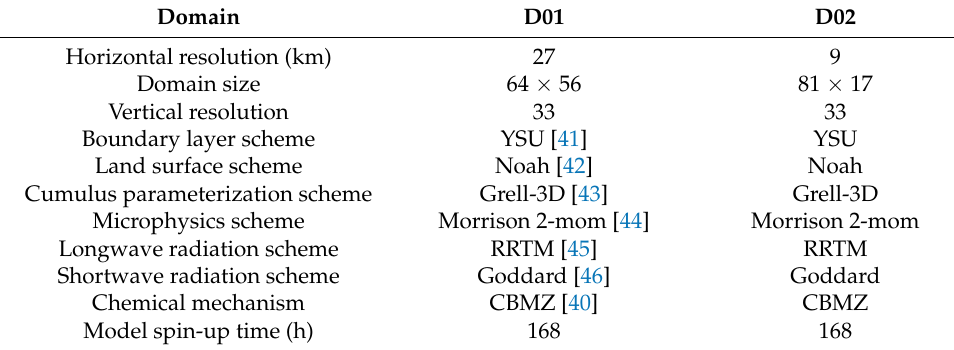
Table 1. WRF-Chem model